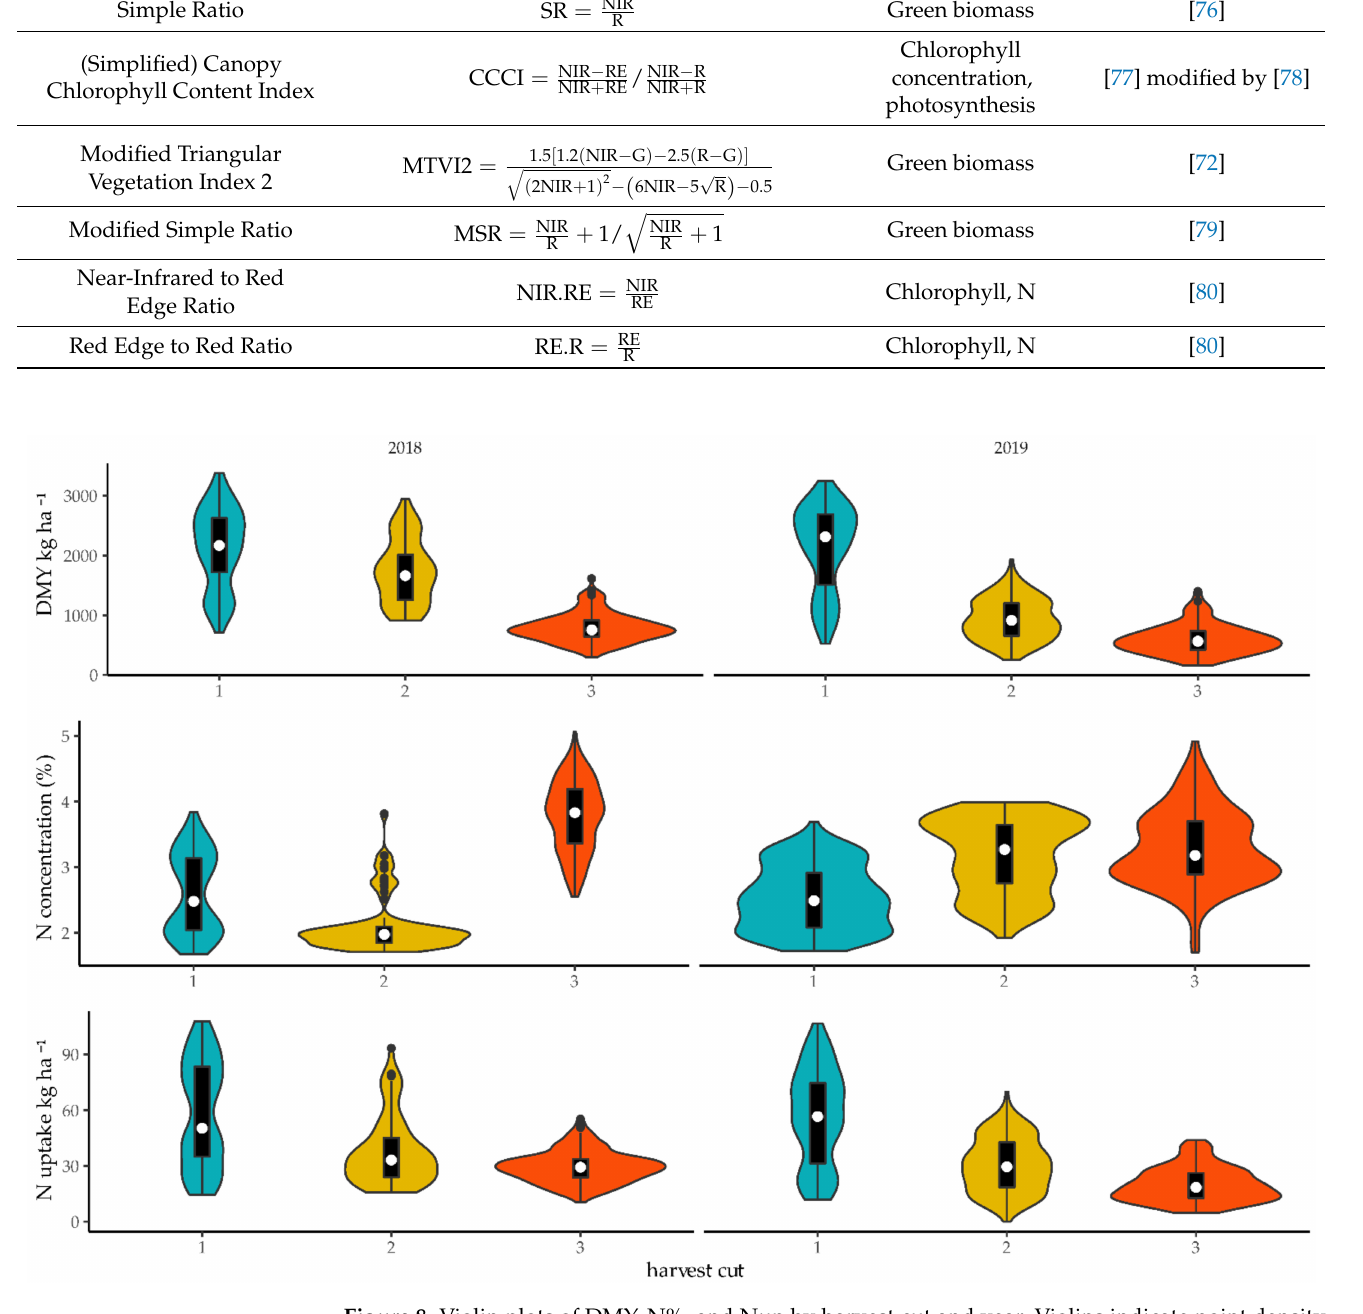
Figure 8. Violin plots of DMY, N%, and Nup by harvest cut and year. Violins indicate point density, black boxes show the 25. and 75. percentiles, whiskers show the 5 and 95 percentiles, and white circles represent the